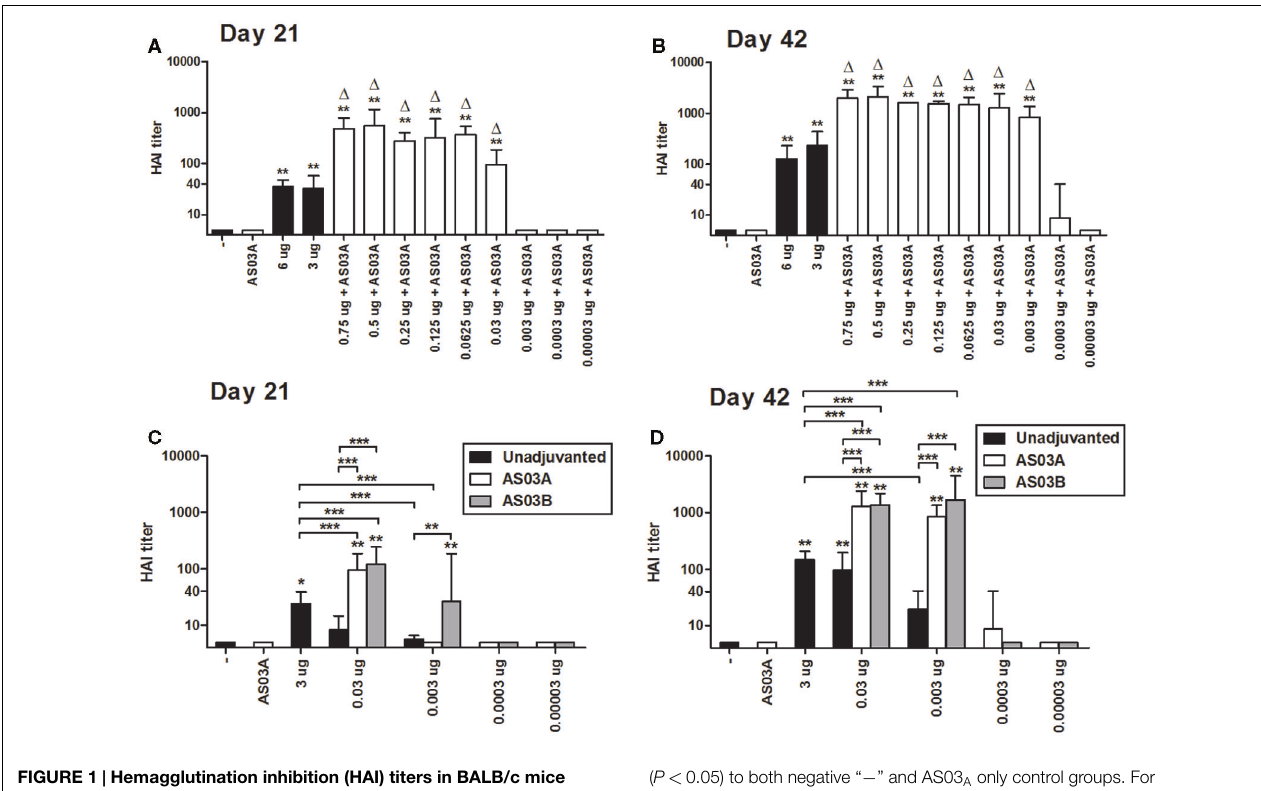
FIGURE 1 | Hemagglutination inhibition (HAI) titers in BALB/c mice after one or two immunizations of unadjuvanted A/Uruguay/ 716/2007 H3N2 split vaccine or AS03-adjuvanted dose-sparing vaccines . Mice were immunized intramuscularly on days 0 and 21, and sera from individual mice were analyzed. HAI titers of mice immunized with AS03 A -adjuvanted vaccines on days 21 (A) and 42 (B) . HAI titers of mice immunized with AS03 A or AS03 B -adjuvanted vaccines on days 21 (C) and 42 (D) . On top of bars, * indicates a significant increase ( P < 0.05) to negative “ − ” group and ** indicates a significant increase